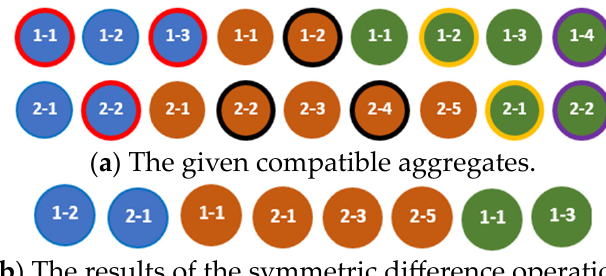
The results of the symmetric difference operation applied to the compatible, quasi- compatible, and incompatible aggregates are shown in Figures 13–15, respectively.